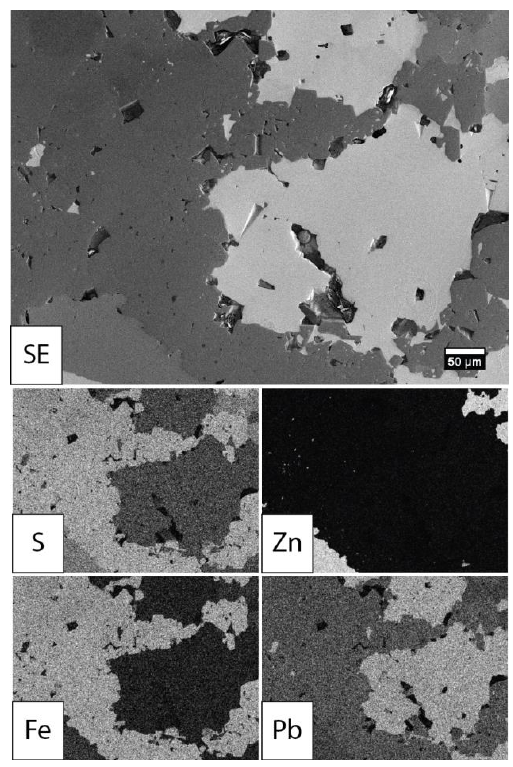
Figure 4. EDS net intensity maps with the corresponding SE image from the galena-rich slag obtained with an accelerating voltage of 5 kV showing that the slag was essentially constituted of iron sulfide, zinc sulfide and lead sulfide. The scalebar displayed on the SE image applies to the corresponding X-ray images. SINGLE COLUMN. J. Imaging 2018 , 4 , x FOR PEER REVIEW